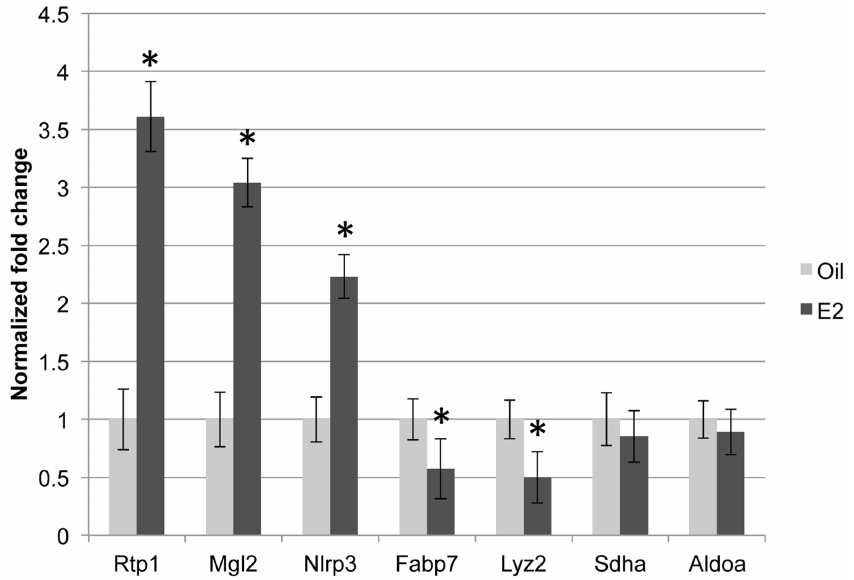
Figure 2. Validation of transcripts altered by E2 treatment. (A) Quantitative real-time PCR was conducted with gene-specific primers. The normalized fold change 6 SEM was calculated using the delta-delta Ct method with Rpl7 as a control gene. The Student’s t-test was used to detect significant differences in oil- and E2- treated animals (4 animals/treatment, * p , 0.05).